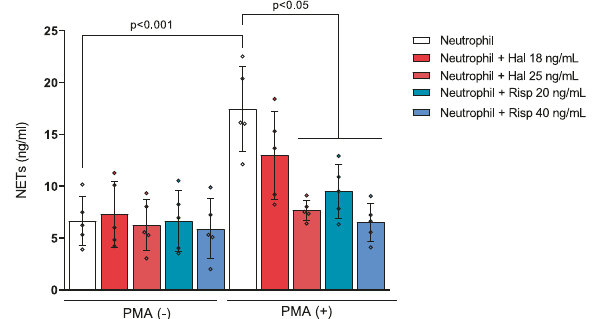
Fig. 2 Antipsychotics do not affect NETs levels in the supernatant of fresh human neutrophils in vitro. Haloperidol (Hal; 25 ng/mL) and Risperidone (Risp; 20 and 40 ng/mL) signi fi cantly inhibited NETs formation induced by PMA. Two-way analysis of variance followed by Bonferroni post-hoc . Data are expressed as mean ±